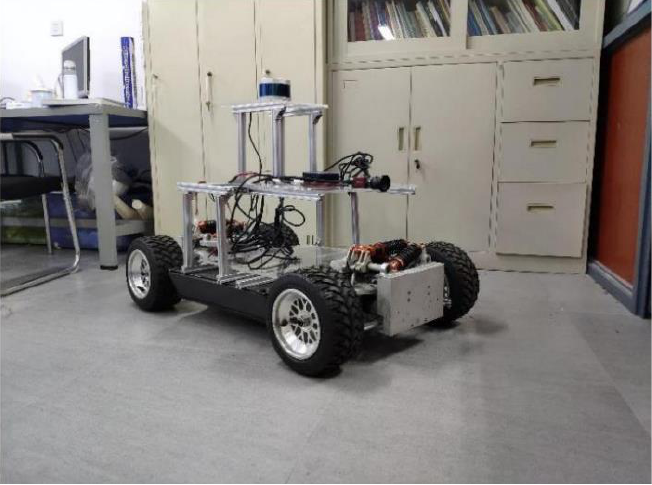
Figure 4. Autonomous driving algorithm experimental platform.